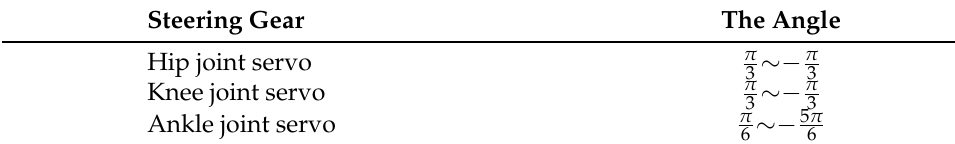
Figure 3. The front view of the leg structure. Table 1. The rotation angle of